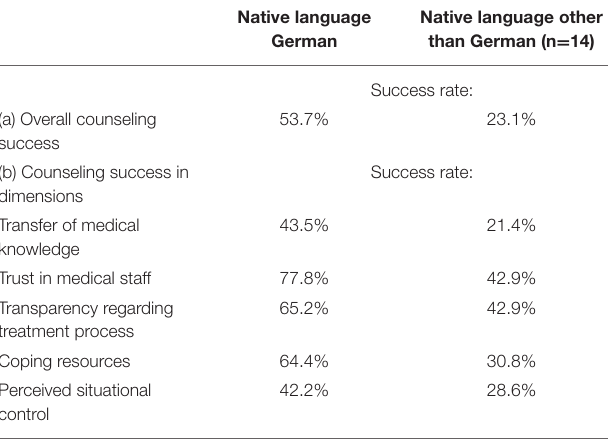
TABLE 4 | Effect of parental native language on overall counseling success and on the five analytical